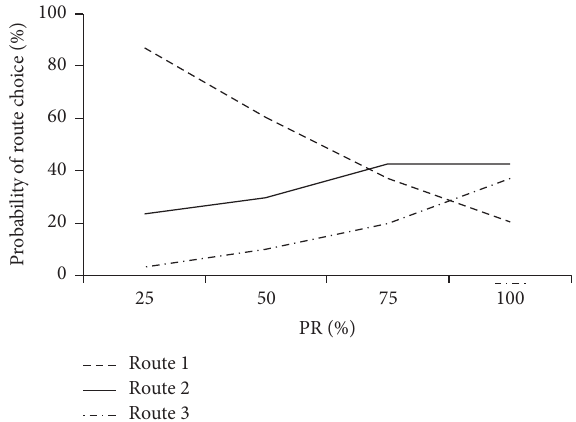
Figure 5: Impact of different PR values on probability of route